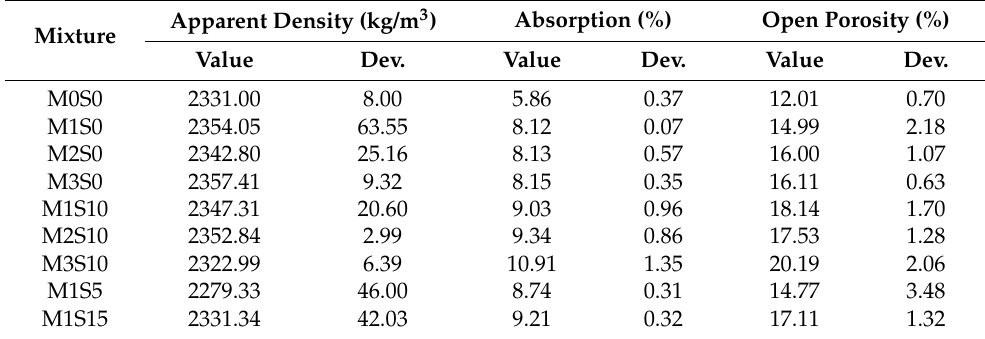
Table 4. Physical properties of the